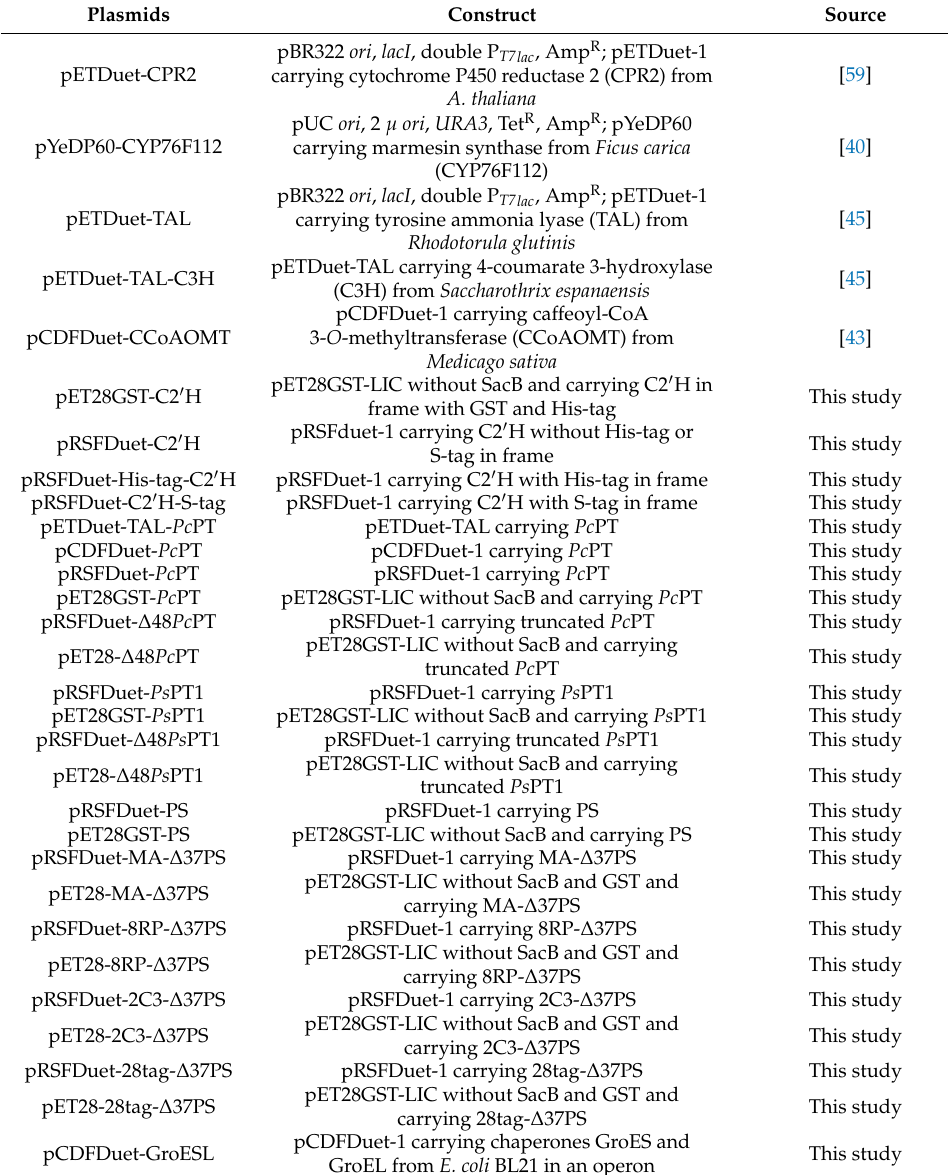
Table 1. Cont. Plasmids Construct